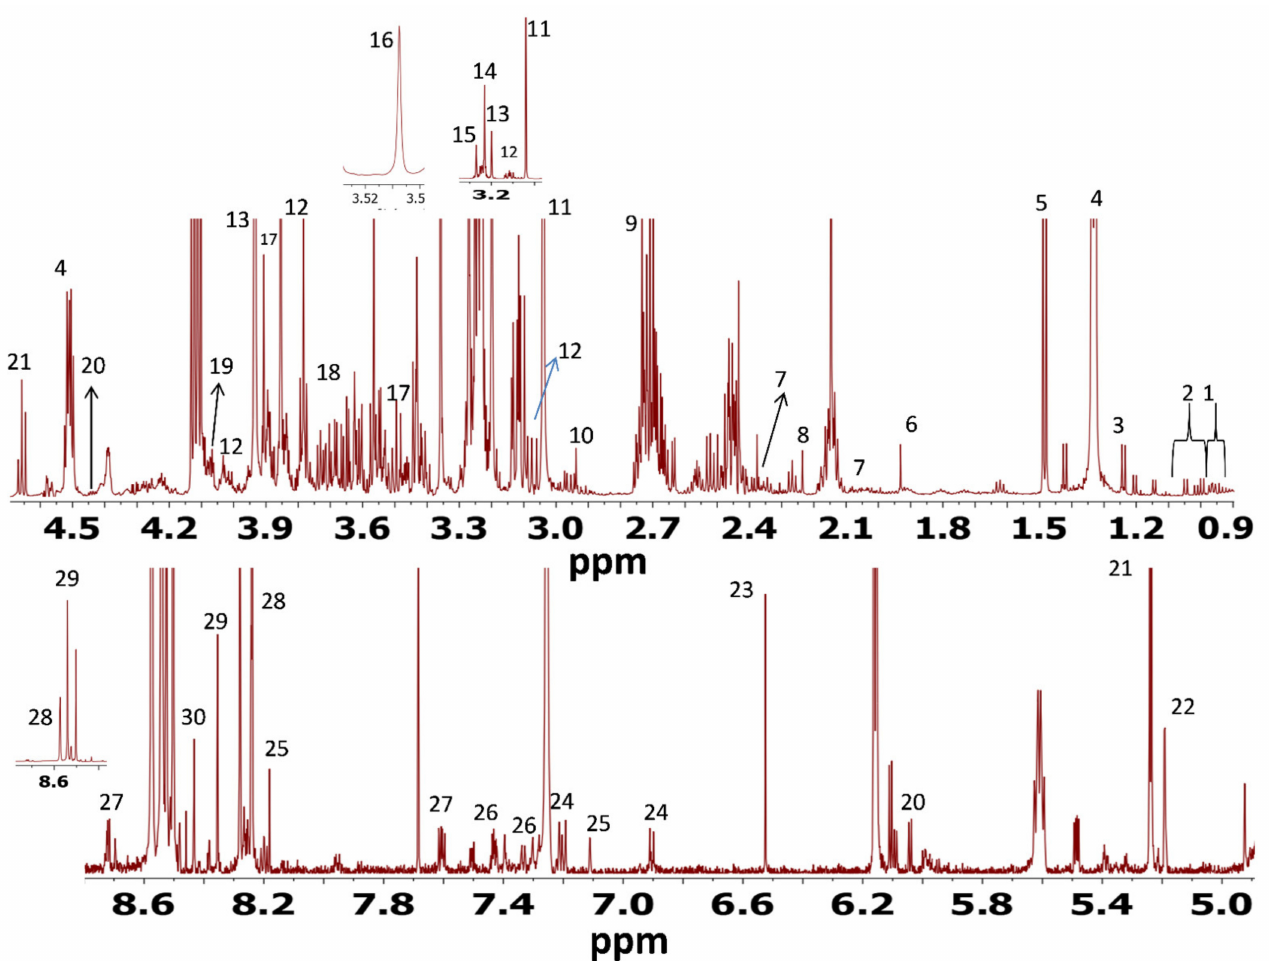
Figure 2. 700 MHz 1 H NMR spectrum of polar extract of Dorper sheep longissimus dorsi muscle tissue: 1. leucine, 2. valine, 3. 3-Hydroxybutyric aci, 4. lactate, 5. alanine, 6. acetate, 7. glutamate, 8. acetone, 9. dimethylamine, 10. trimethylamine, 11. creatine, 12. anserine, 13. glycerophosphocholine, 14. carnitine, 15. betaine, 16. glycine, 17. glutamine, 18. glycerol, 19. choline, 20. inosine, 21. glucose, 22. a-Mannose, 23. fumarate, 24. tyrosine, 25. carnosine, 26. phenylalanine, 27. niacinamide, 28. IMP, 29. ADP/AMP/ATP, and 30.